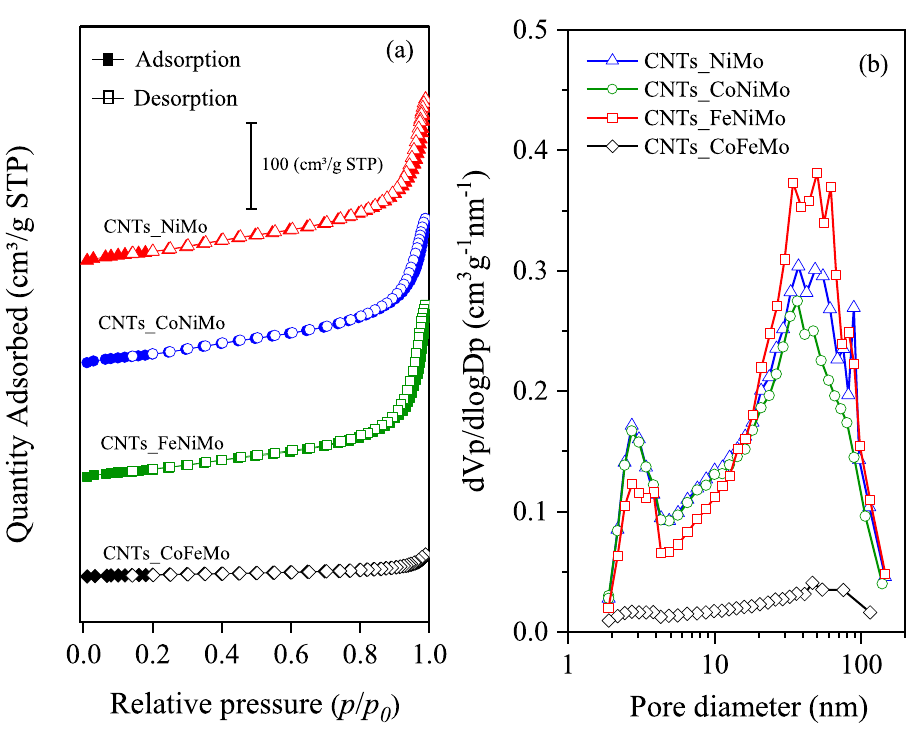
Figure 9. ( a ) N 2 adsorption–desorption isotherms and ( b ) pore size distribution of synthesized CNTs over different catalysts with 800